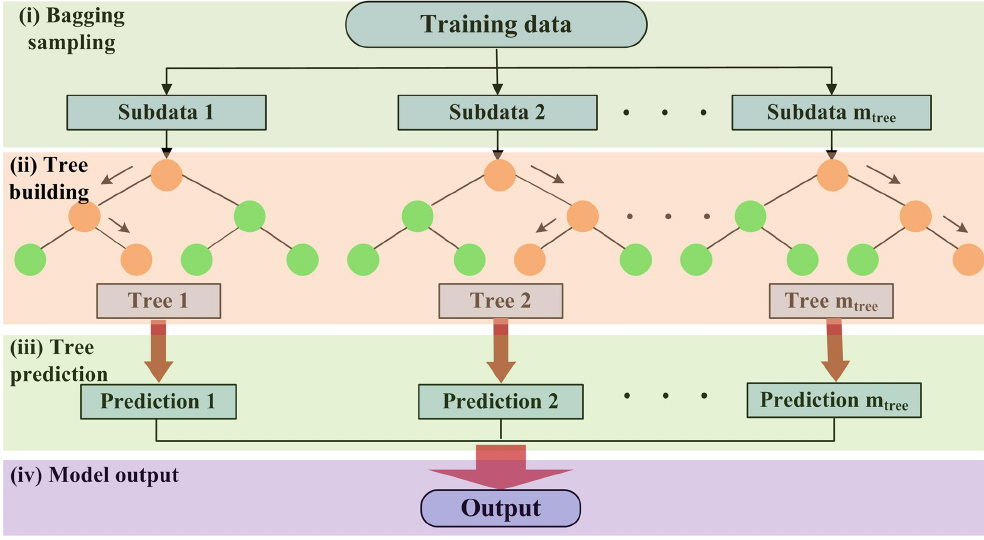
Figure 4. General framework of the